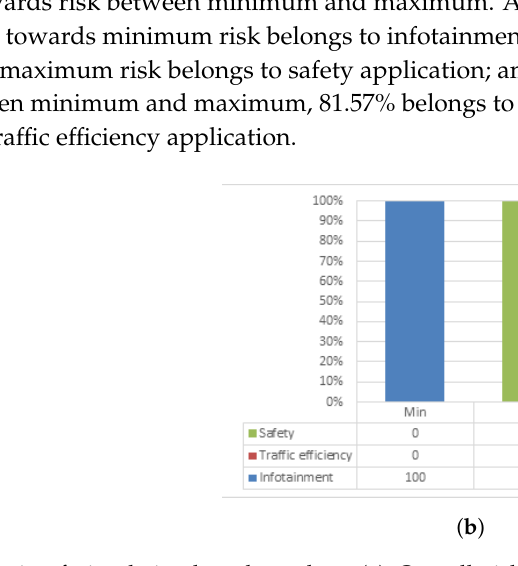
Figure 10. Statistical analysis of simulation-based results. ( a ) Overall risk level distribution; ( b ) Application specific risk